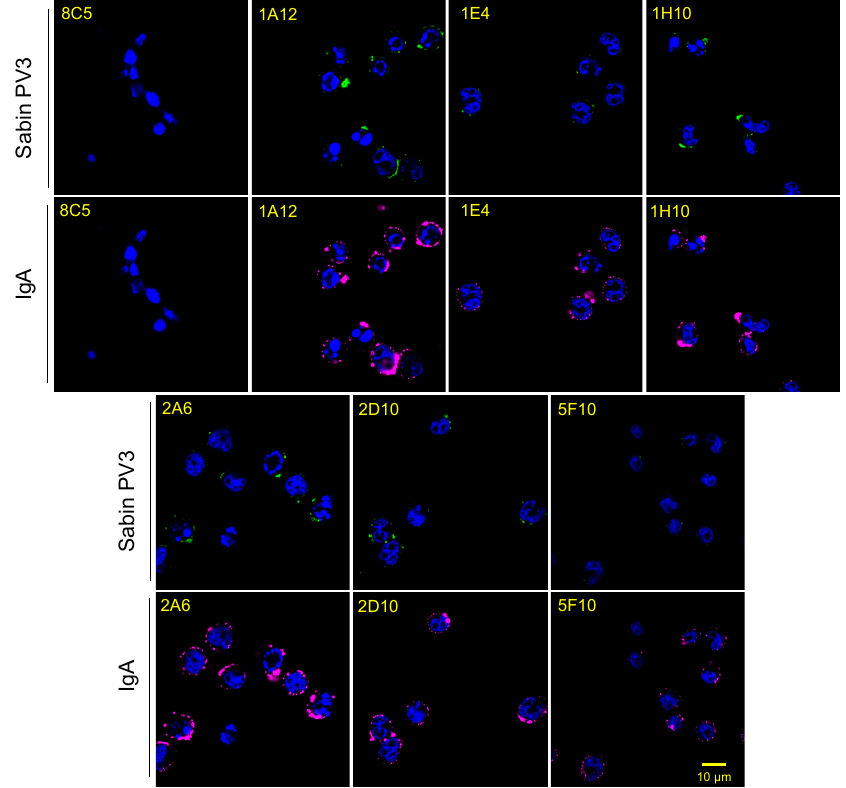
Figure 3. Binding of type 3 PV to OCMS hybridomas secreting anti-PV IgA mAbs. Hybridomas were incubated overnight with the rabbit mAb specific for human IgA and then with biotinylated PV. Human IgA and PV3 binding to the cells were detected with an Alexa-Fluor 647 anti-human IgA secondary and Alexa-Fluor 488 conjugated streptavidin, respectively. Nuclei were stained with DAPI. Scale bar = 10 μ m.